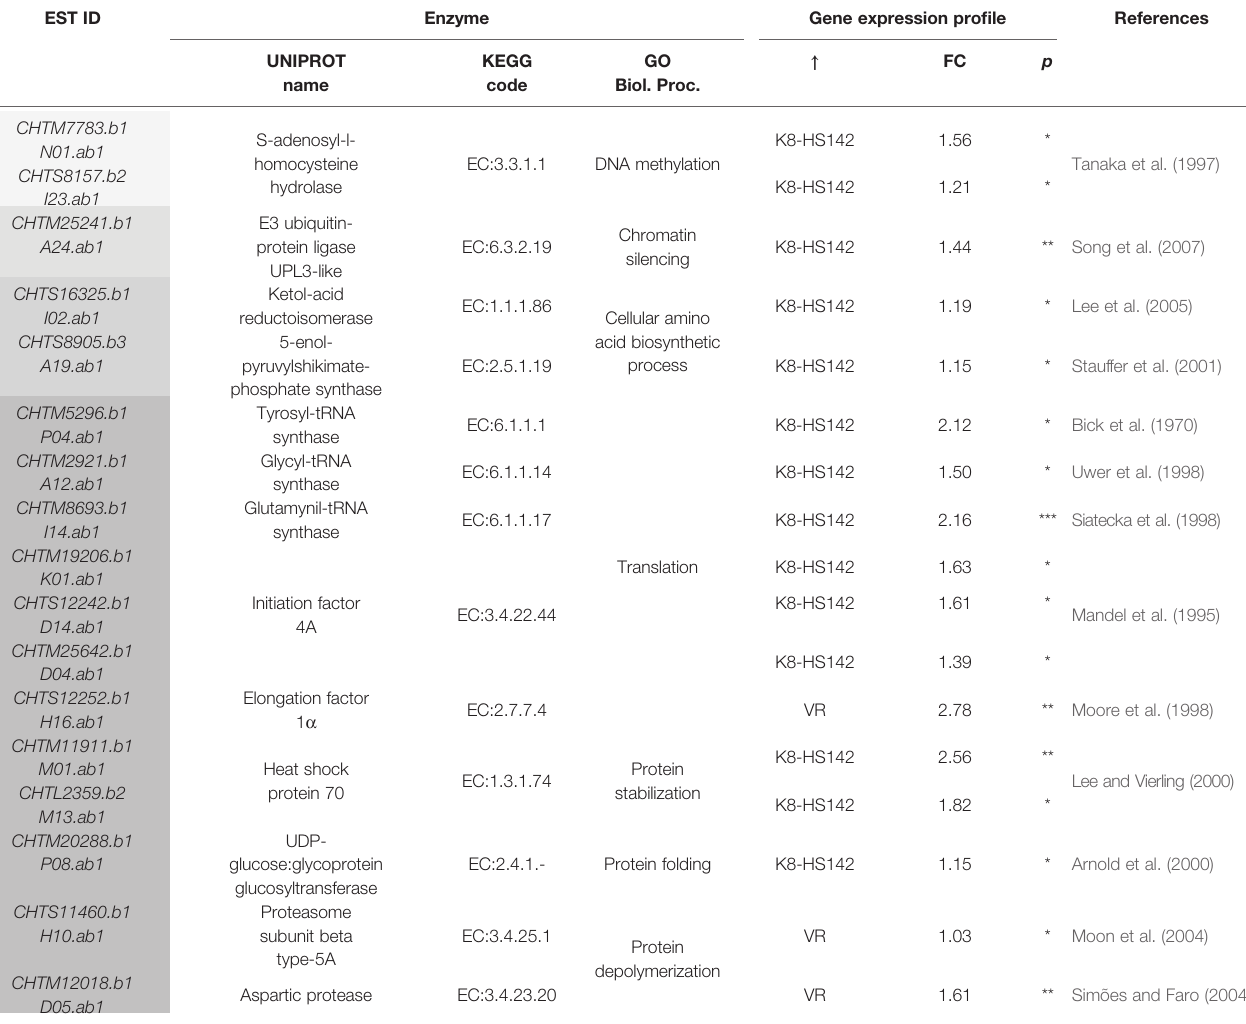
TABLE 5 | Differentially expressed (DE)/expressed sequence tags (ESTs) between clones at T 0 taking a role in the metabolism of nucleic acids and proteins. EST ID Enzyme Gene expression pro fi